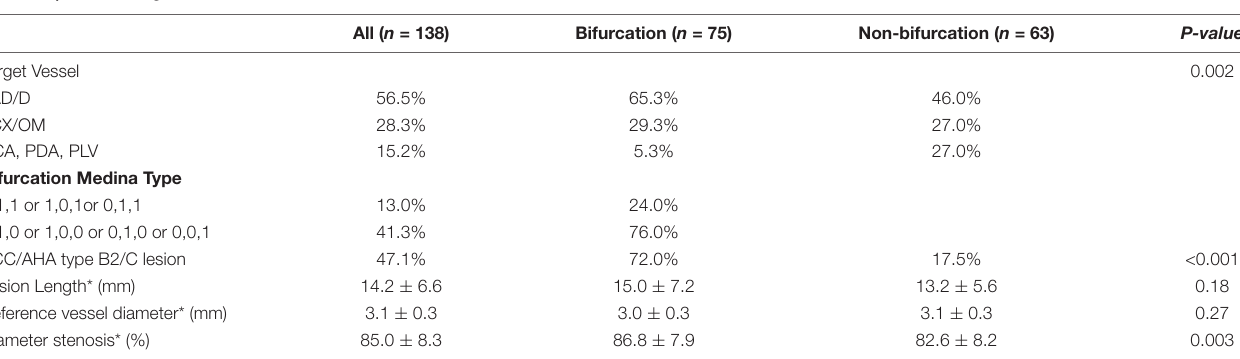
TABLE 2 | Baseline target lesion